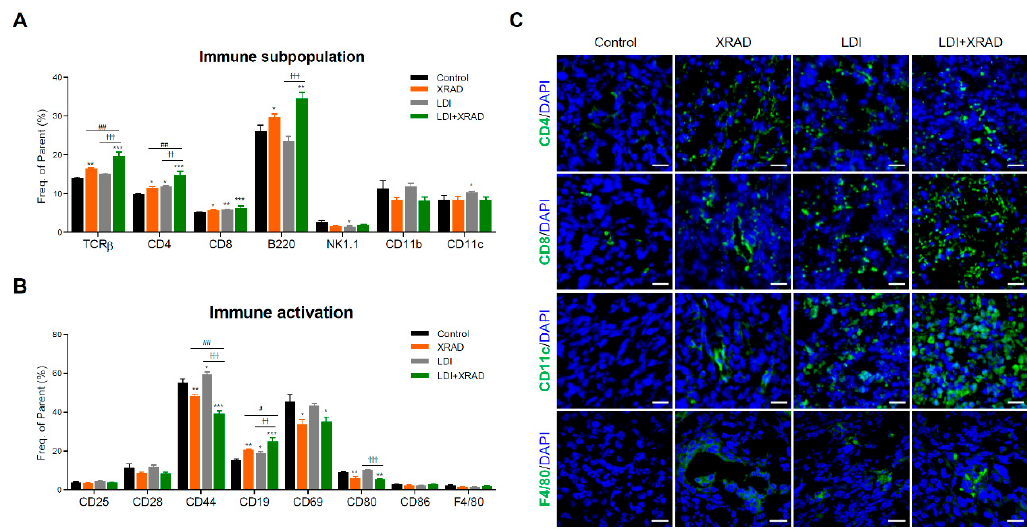
Figure 5. LDI significantly increases immune subpopulation and activation in splenocytes. ( A ) Subpopulation of splenic immune cells and ( B ) activation markers in the spleen were labeled using fluorescence-labeled monoclonal antibodies and examined by flow cytometry. Data represent means ± SEM of 6-8 mice per experiment. * p < 0.05, ** p < 0.01, *** p < 0.001 vs. control, †† p < 0.01, ††† p < 0.001 vs. LDI, # p < 0.05, ## p < 0.01 vs. XRAD. ( C ) Representative confocal sections showing immune cell recruitment including CD4, CD8, CD11c and F4 / 80 I then secondary tumor site were detected by immunofluorescence staining. Cell nuclei are stained blue by DAPI. Scale bar, 20 μ m.